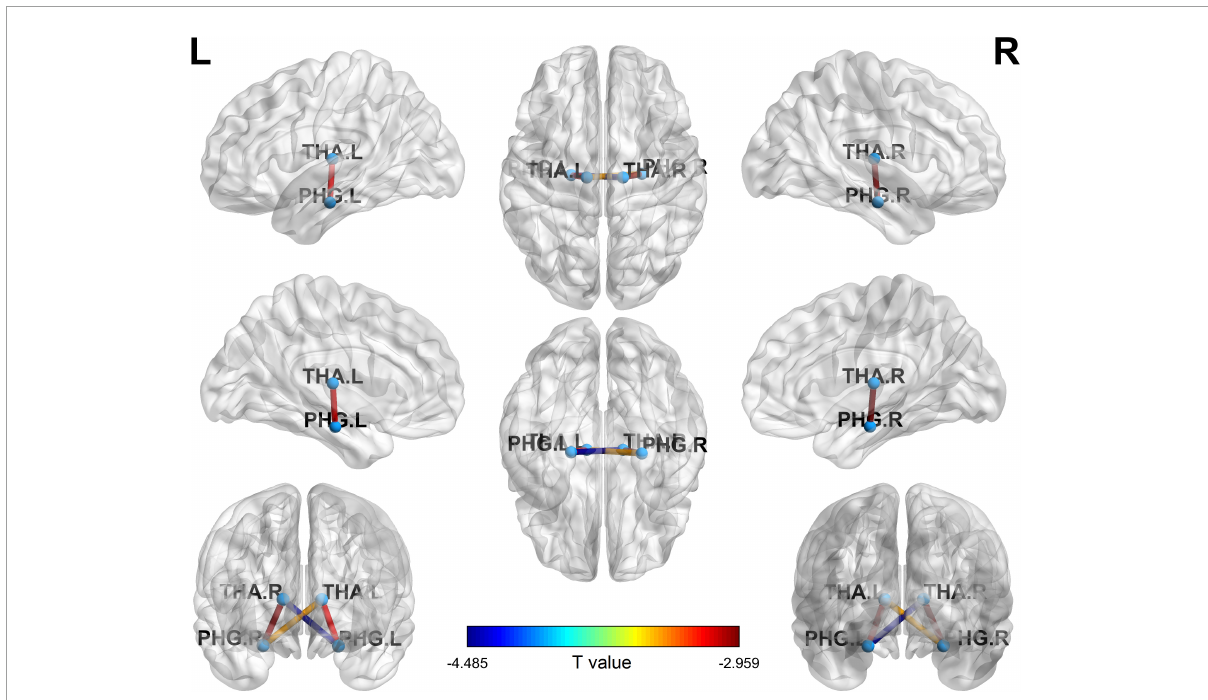
FIGURE2 Four ROI to ROI FC significantly decreased in CDs compared with HCs. ROI, region of interest; FC, functional connectivity; CD, Crohn’s Disease; PHG.L, left parahippocampal gyrus; PHG.R, right parahippocampal gyrus; THA.L, left hippocampus; THA.R, right